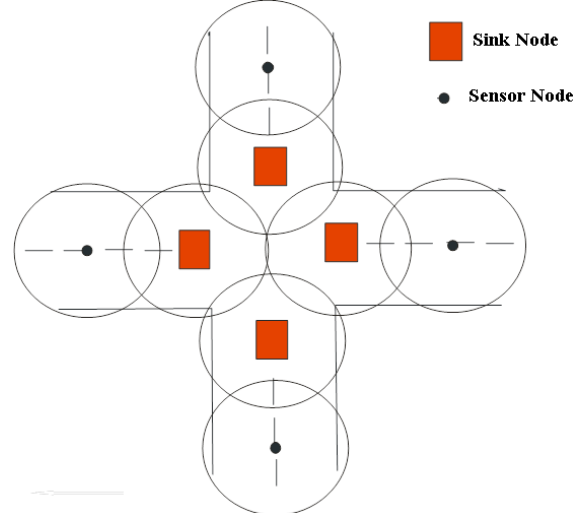
Figure 2. ATM system with